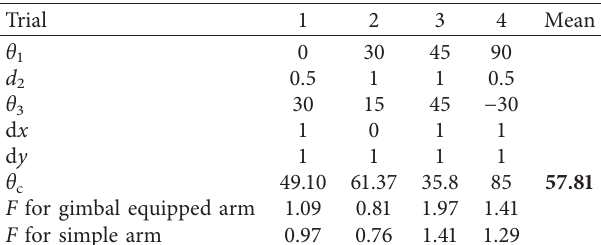
Table 3: GA optimization results for RPR arm